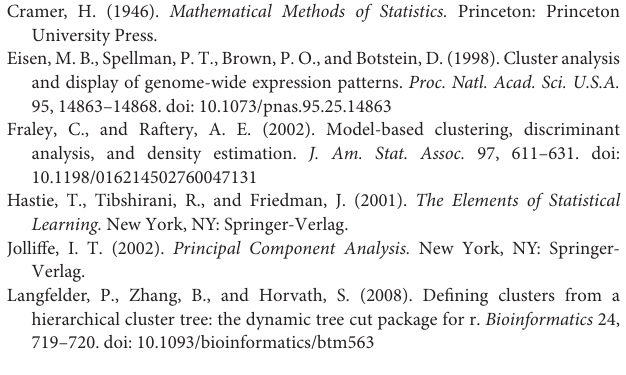
significance for each clade of the dendrogram. Similar